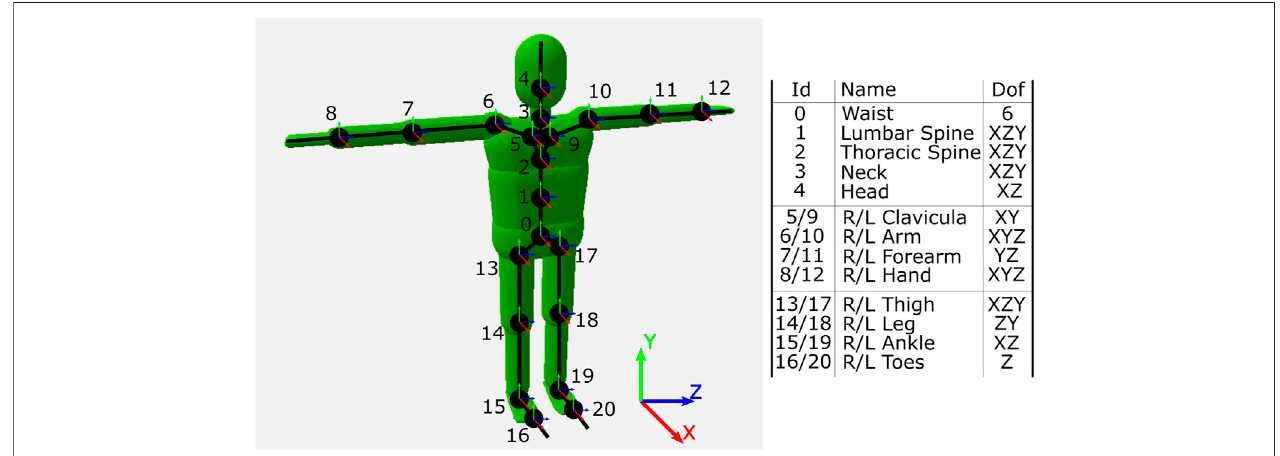
FIGURE 7 | The digital human model used in the SEEROB framework. It contains 21 bones and a total of 53 degrees of freedom (dofs).